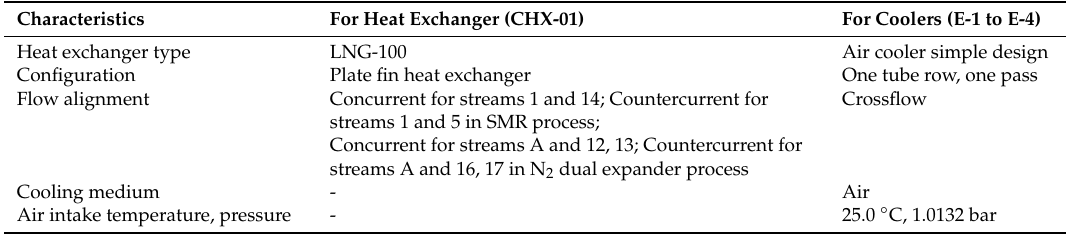
Table 4. Heat exchanger model for SMR and N 2 dual expander LNG